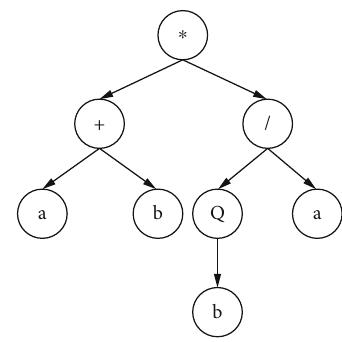
Figure 2: Expression tree corresponding to Equation